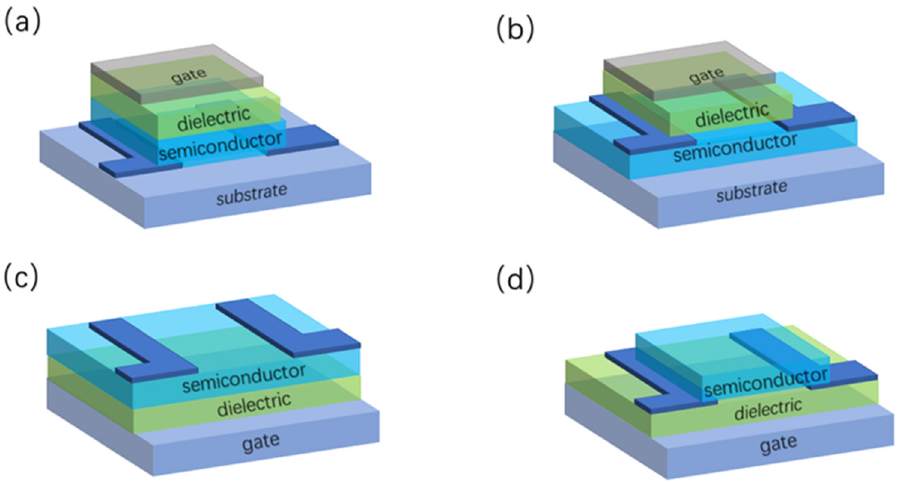
Figure 4. TFT structure, divided by the position of the source-drain and gate: ( a ) bottom-gate-top contact types; ( b ) bottom-gate-bottom contact types; ( c ) top-gate-top contact types; ( d ) top-gate- bottom contact types.